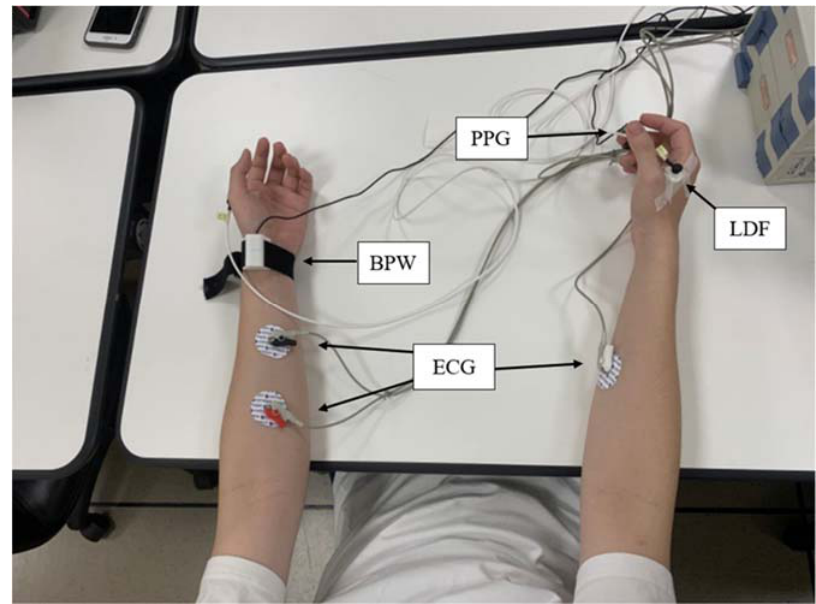
Figure 1. Experimental setup.